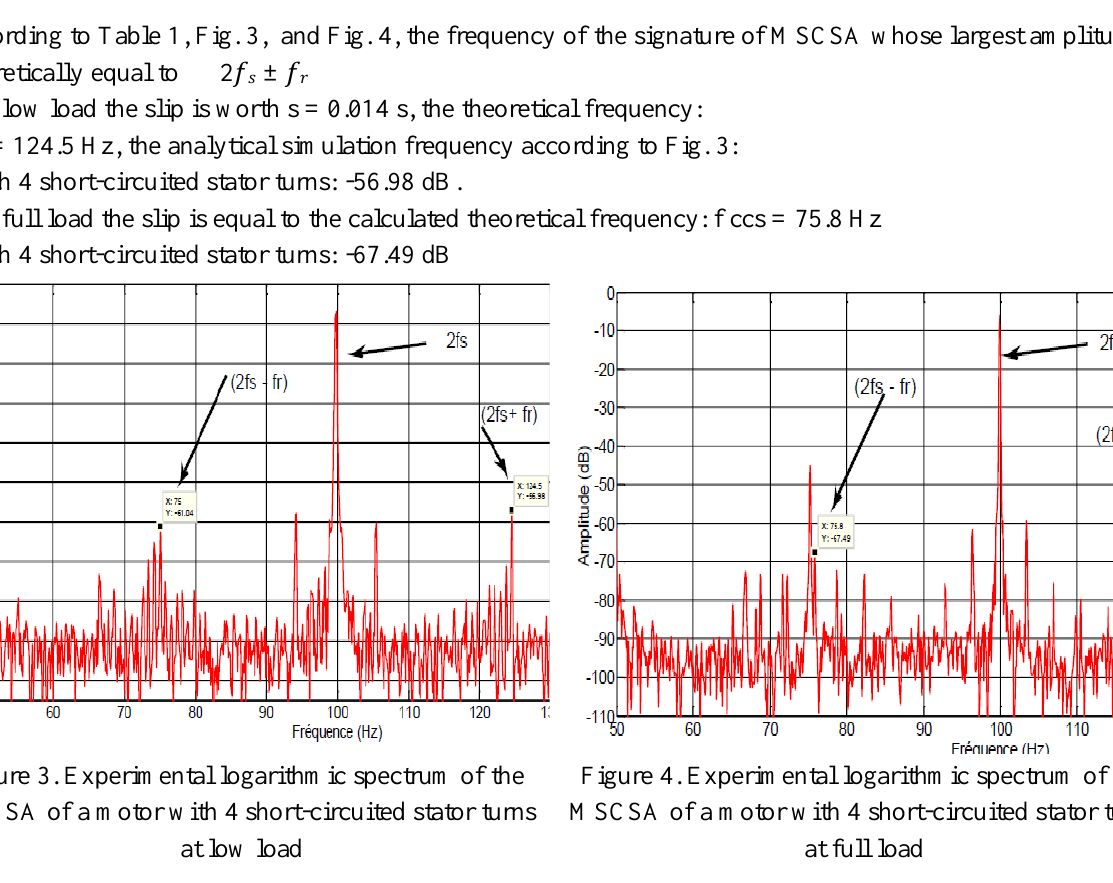
Figure 1. Experimental logarithmic spectrum of the Figure 2. Experimental logarithmic spectrum of the MCSA of a motor with 4 short-circuited stator turns MCSA of a motor with 4 short-circuited stator turns at at low load full load